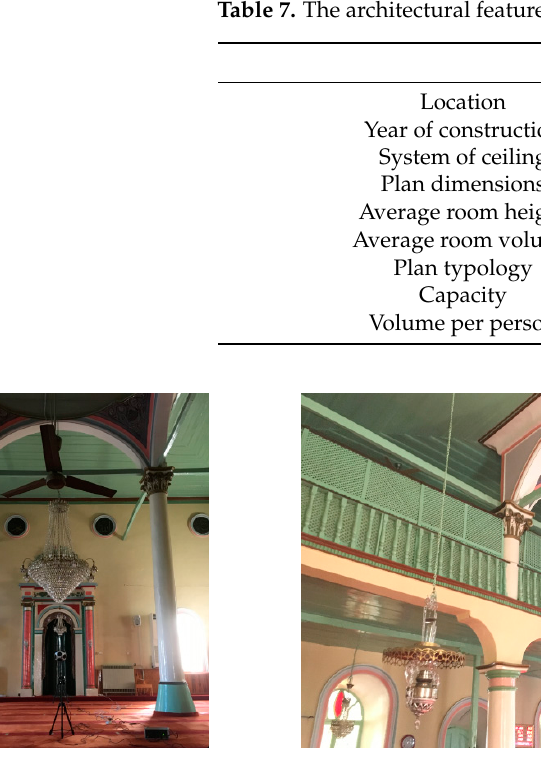
Figure 8. Main and women’s prayer hall of Çar ş ı Mosque (photos by the authors) .